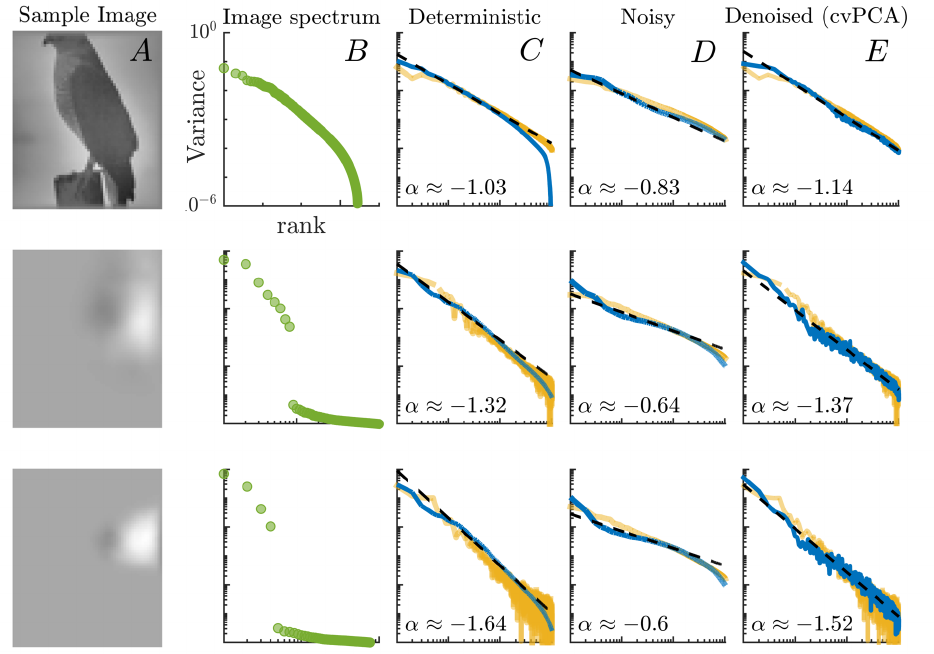
Figure 3. From left to right: ( A ) sample from the M = 2800 images in the training set; ( B ) eigenspec- trum of the images pixel intensities; ( C ) eigenspectrum for the activities of an echo state network (blue line) and actual, V1 mouse neurons (yellow line, plotted after [20] applying cross-validated PCA; see Materials and Methods) when subject to images of dimensionality d ; ( D ) same analysis, but now zero-centered white noise of amplitude ξ = 0.4 is added to the neuron dynamics (blue line), and no cvPCA is performed over the experimental values (yellow line); ( E ) same analysis as in ( D ), but now noise has been subtracted using cvPCA. From top to bottom: results for natural, high-dimensional images; the same images projected onto 8 dimensions; the same images projected onto 4 dimensions. To obtain the ESNs eigenspectra, parameters were chosen so that the networks operated near the edge of chaos, with λ ∼ − 5 × 10 − 3